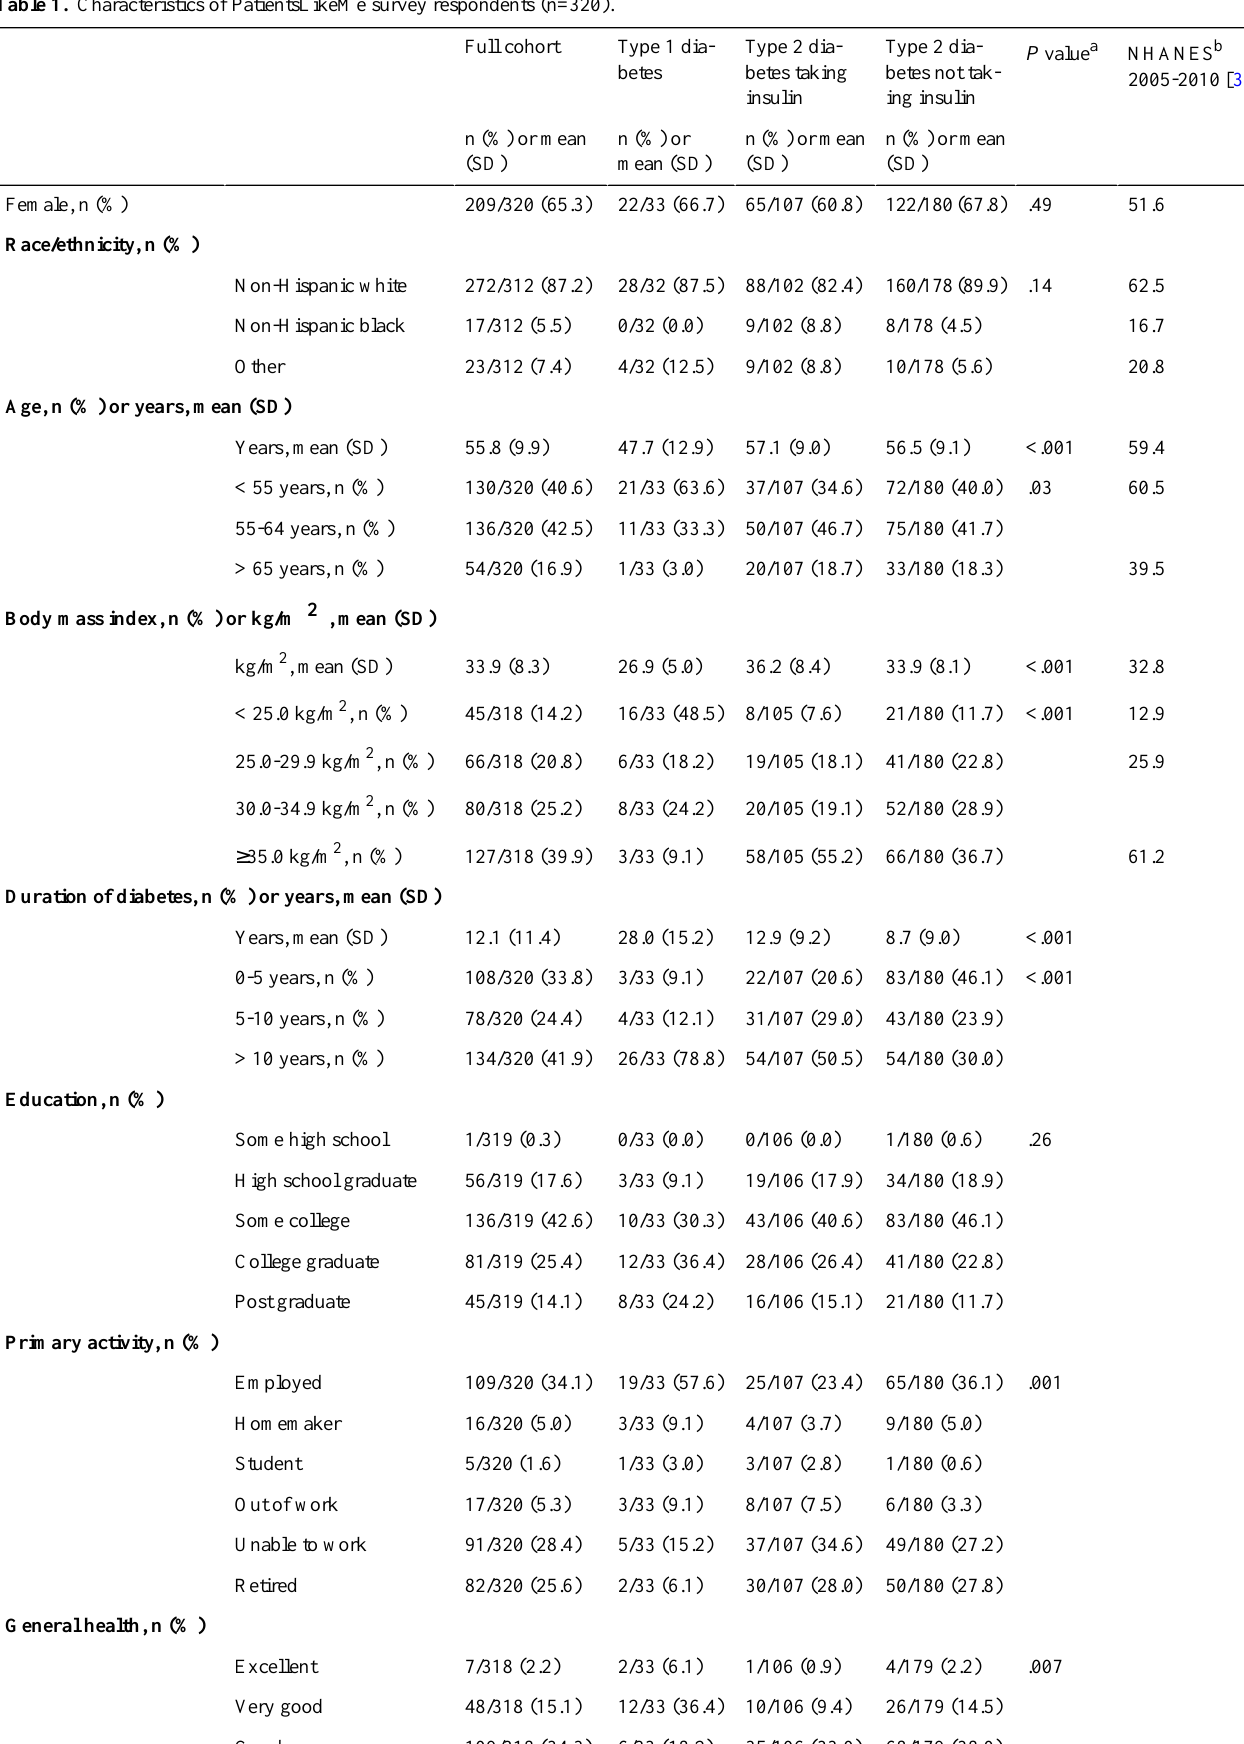
Table 1. Characteristics of PatientsLikeMe survey respondents